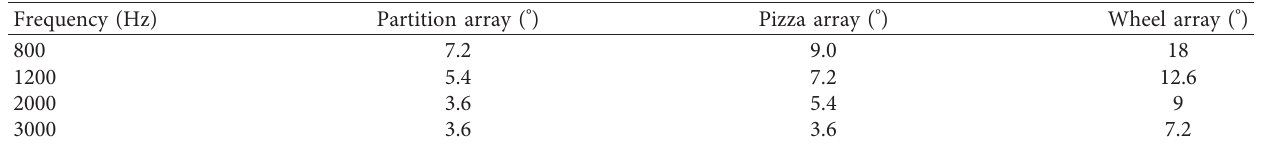
Figure 10: Angle separation ratio of two sources of the same level with a 10dB SNR using three arrays at different frequencies: (a) 800Hz; (b) 1200Hz; (c) 2000Hz; (d) 3000Hz. Table 3: The smallest separated